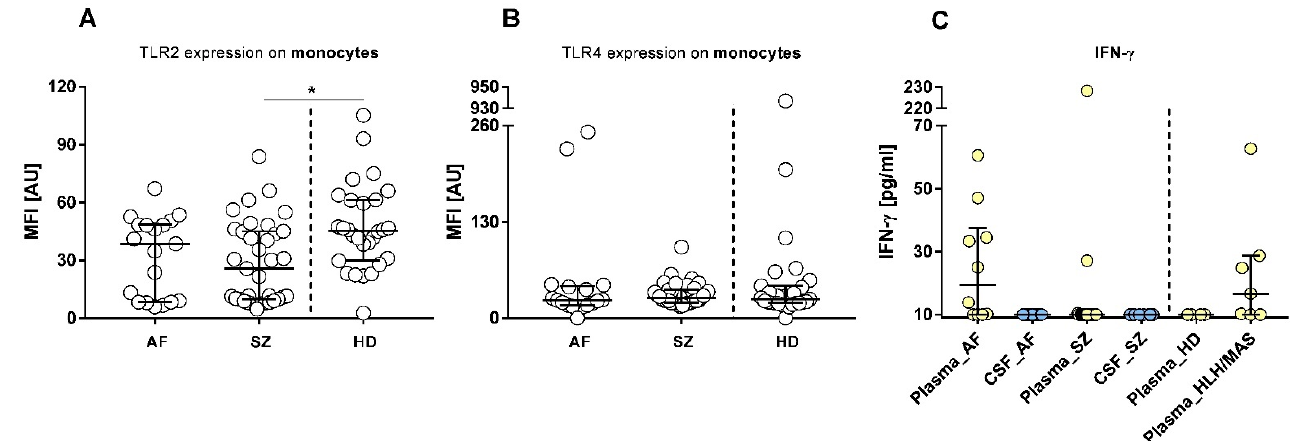
Figure 4. Flow cytometric profiles of pathogen receptors TLR2 and TLR4 on monocytes of patients with AF, SZ, and HDs, and IFN- γ plasma and CSF determinations of patients with AF, SZ, HDs, and patients with HLH/MAS. Monocyte expression densities of TLR2 (SZ/HDs: median: 25.79 vs. 45.35, p = 0.003) ( A ) and TLR4 ( B ) are shown and given as mean fluorescence intensities (MFI) or arbitrary units (AU). Plasma and CSF IFN- γ concentrations are shown ( C ). Bars indicate the medians, including interquartile ranges. Wilcoxon rank-sum test was performed to analyze differences among groups, with significant differences being marked by * p ≤ 0.05.